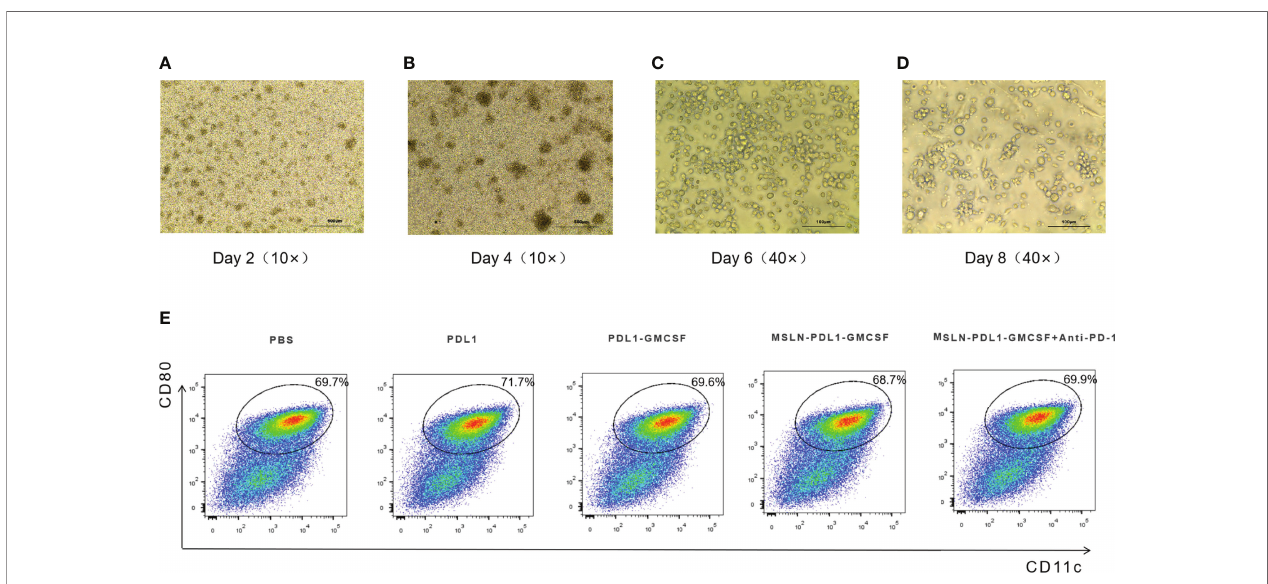
FIGURE 2 | Morphology of murine BMDCs at different days of culture and costimulatory molecule (CD80 and CD11c) expression of murine mature-BMDCs. Murine bone marrow cells were cultured in RPMI-1640 with 10% FBS containing 20ng/ml recombinant mouse GM-CSF and 10ng/ml IL-4 for 8 days. Fresh medium was supplemented every two days. (A) Murine bone marrow cells at day 2. (B) BMDCs at day-4. (C) Immature un-treated-BMDCs at day 6. (D) BMDCs were loaded with different fusion proteins (PBS, PDL1, PDL1-GMCSF, MSLN-PDL1-GMCSF) at day 7 and then after 4 hours, stimulated by LPS (1 m g/ml) for another 24 hours. (E) The expression levels of the maturation-stimulating molecules CD80 and CD11c in BMDCs were analyzed by surface staining and fl ow